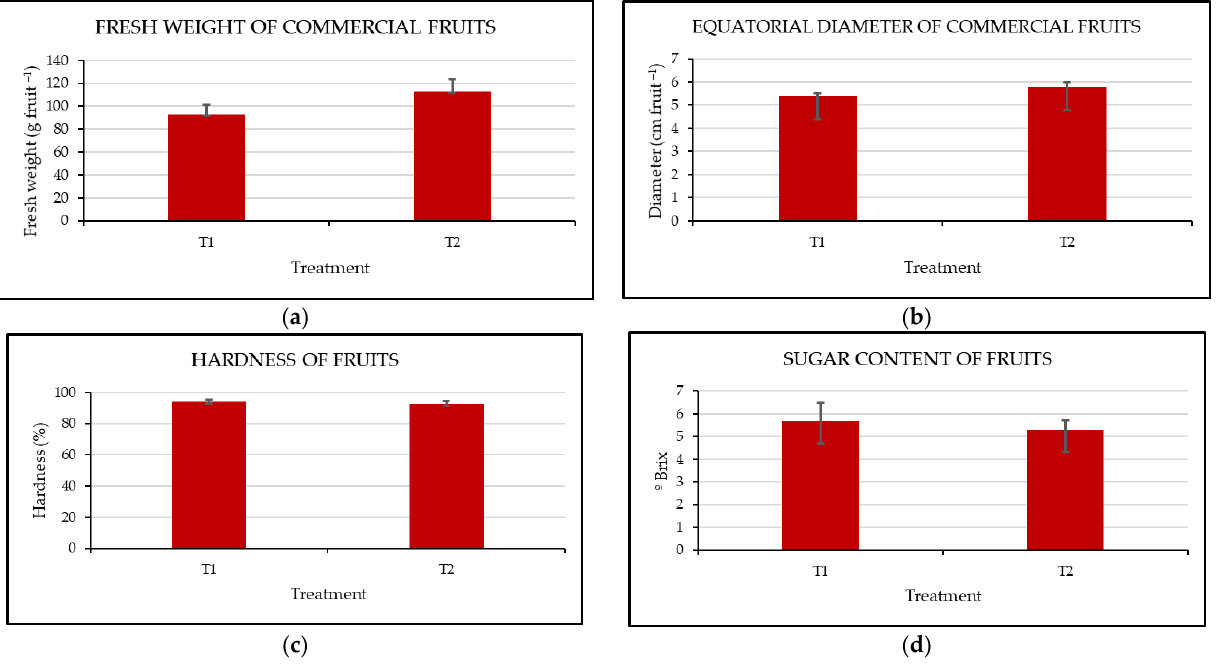
Figure 10. Qualitative characteristics of tomato crops grown in soil: ( a ) fresh weight of commercial fruits; ( b ) equatorial diameter of commercial fruits; ( c ) hardness of commercial fruits; ( d ) sugar content of commercial fruits.